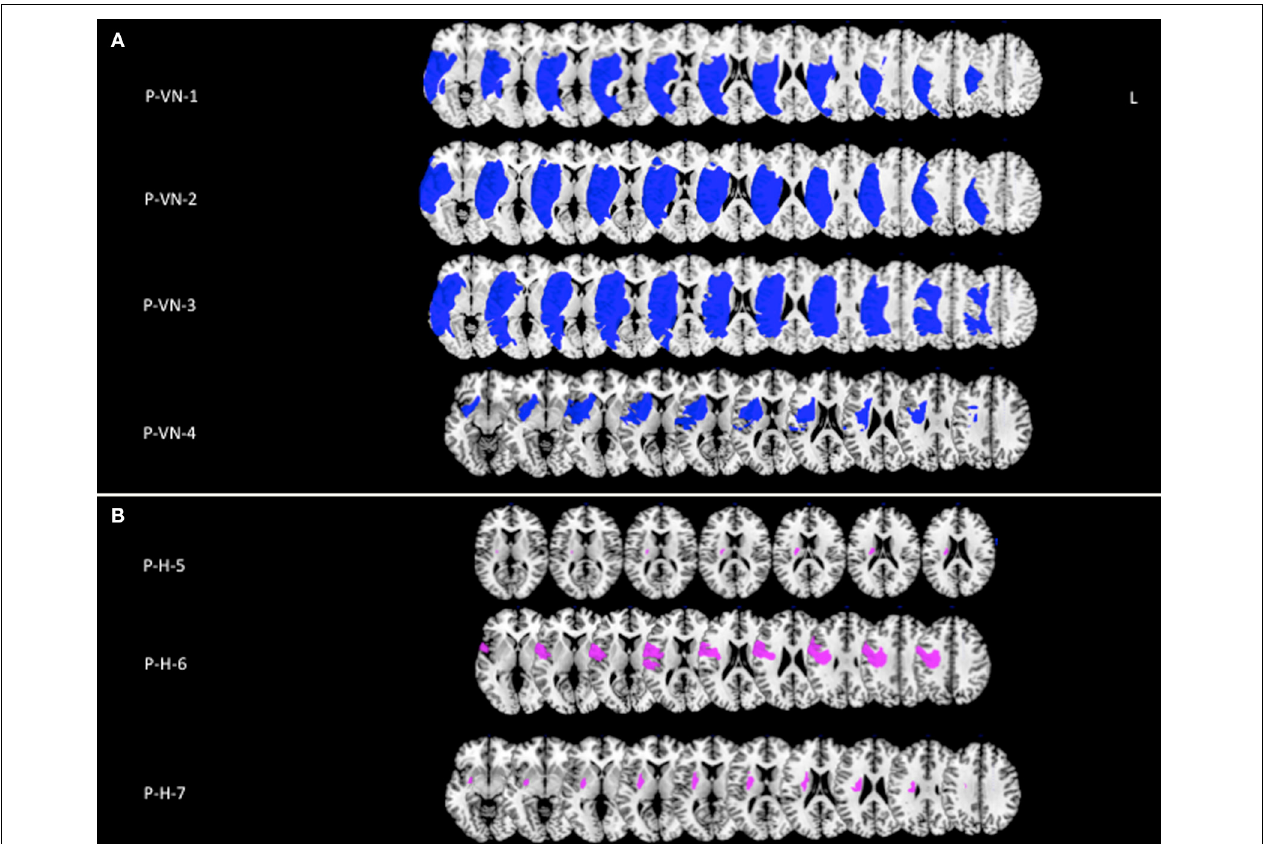
FIGURE 4 | Voxel-based lesion symptom mapping in MN patients vs . the control groups. Lesion overlap contrast yielded maximal involvement of the anterior cingulum shown in red. The trajectory of the cingulum bundle (Thiebaut de Schotten et al., 2011b) is displayed in blue.